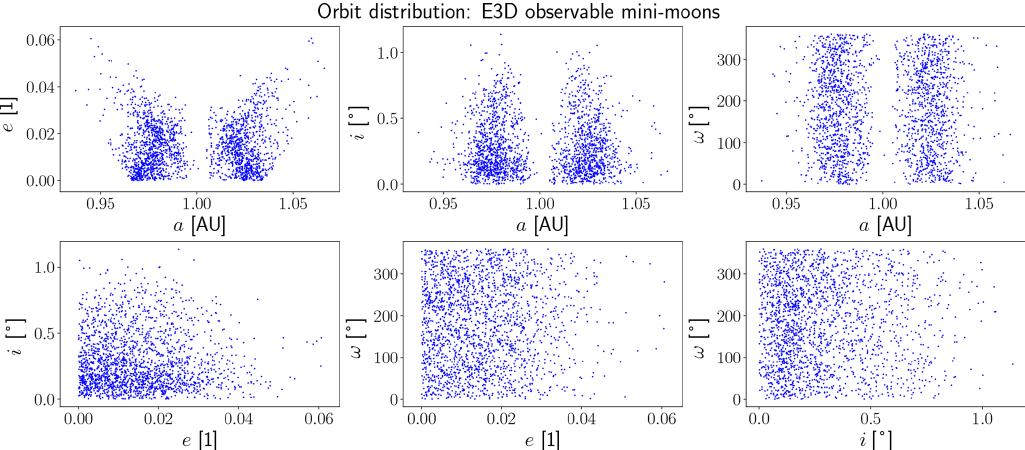
Figure 7. Orbital element distribution of mini-moons that can be tracked by E3D. This is not the detected orbital element distribution but rather what part of the initial distribution is observable. This illustration should be compared to the initial distribution in Fig. 2.